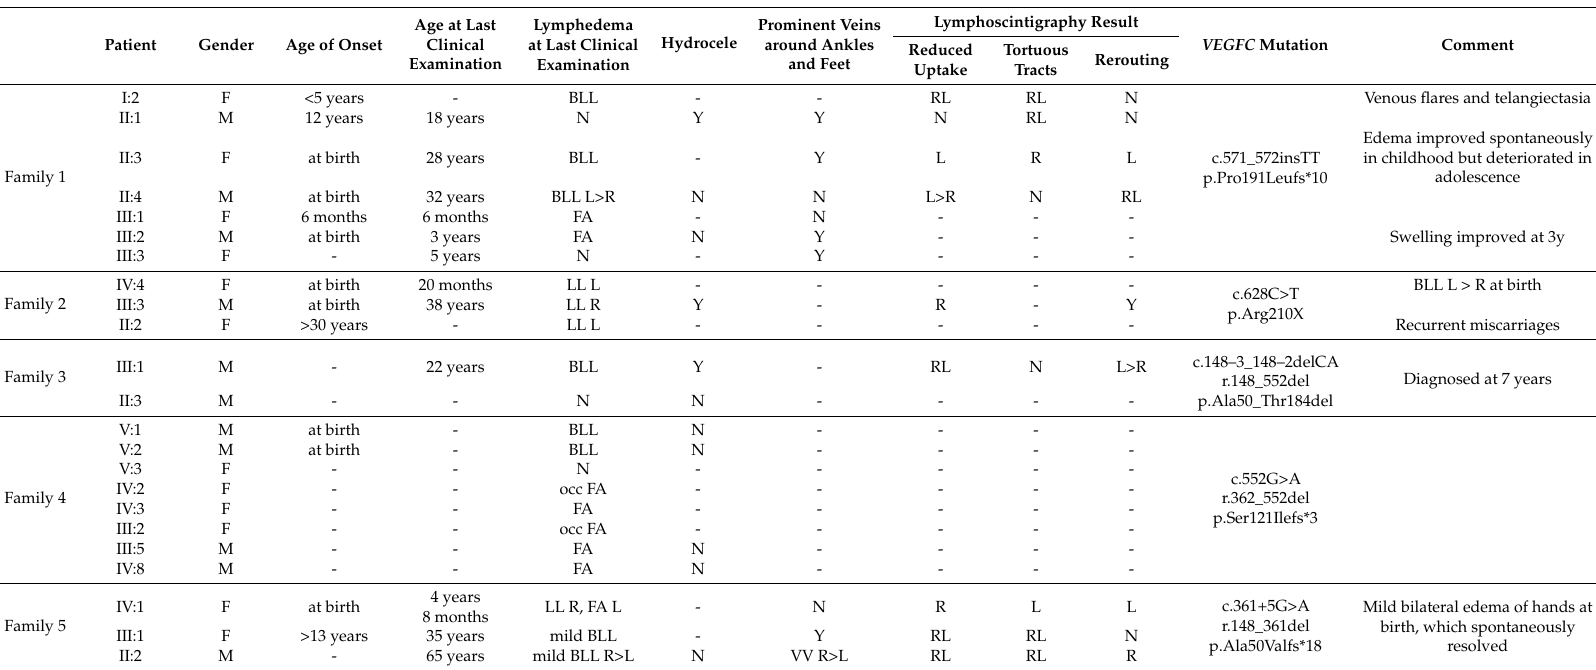
Table 1. Summary of findings of VEGFC mutation positive patients published to date. Family 5 is the current case. BLL, bilateral lower limb lymphedema extending to below knee. FA, lymphedema confined to feet and ankles. L, left. LL, lower limb lymphedema extending below the knee. N, not present. occ, occasional. R, right. VV, varicose veins. Y, yes. - not recorded or not applicable. Family 1 [6]. Family 2 [7]. Family 3 and Family 4 are published as LE-627 and LE-445, respectively, in Fastre et al. [8]. Family 5: this case